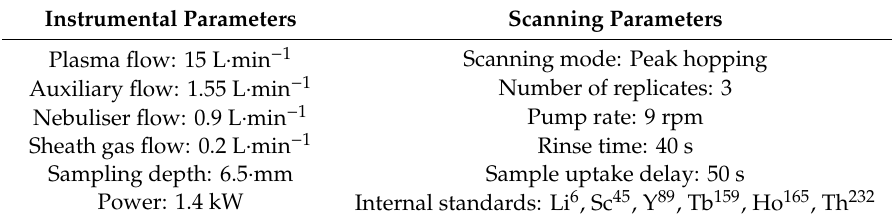
Table 1. Ion-coupled plasma mass spectrometer (ICP-MS) settings. Instrumental Parameters